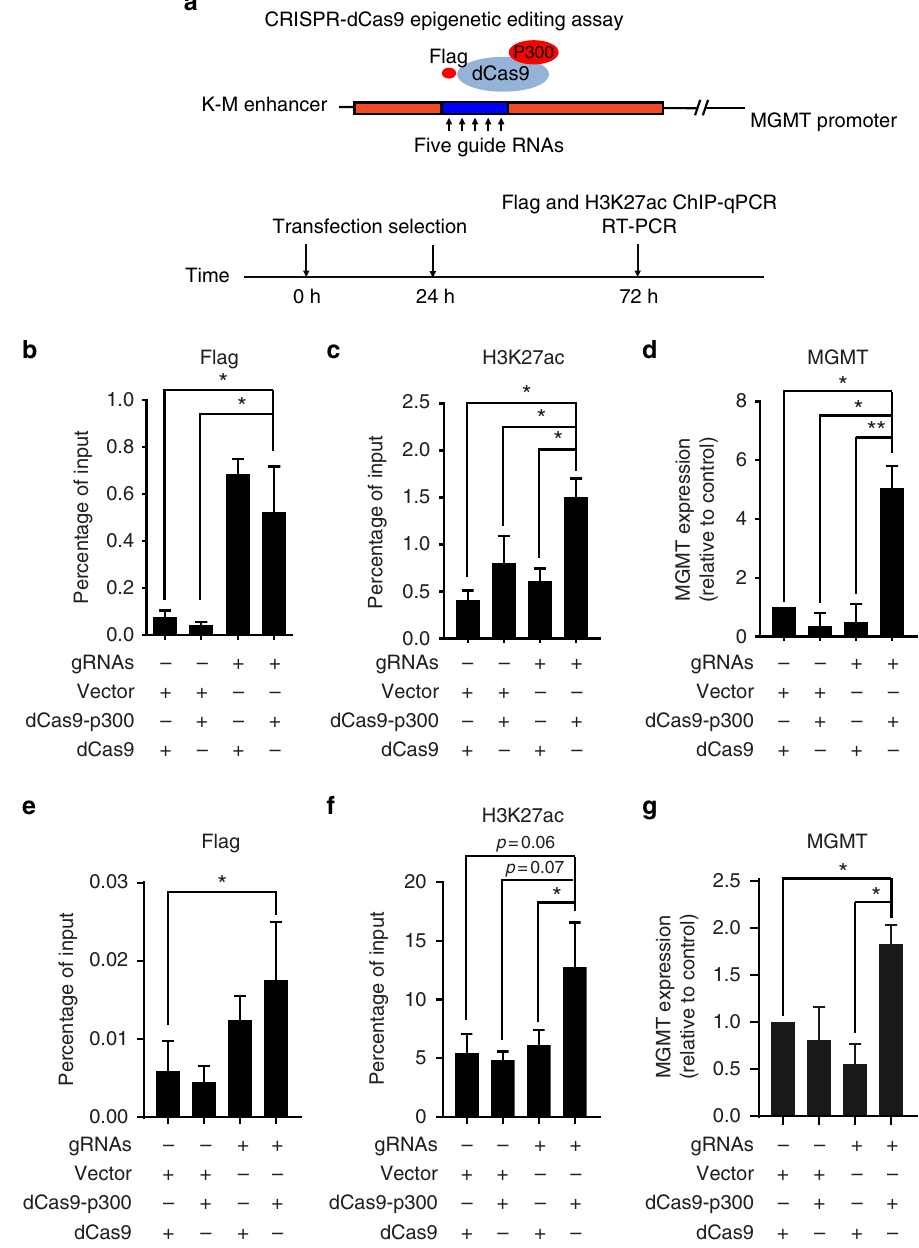
Fig. 4 Targeting p300 to the K-M enhancer increases MGMT gene transcription. a Schematic diagram showing procedure of targeting p300